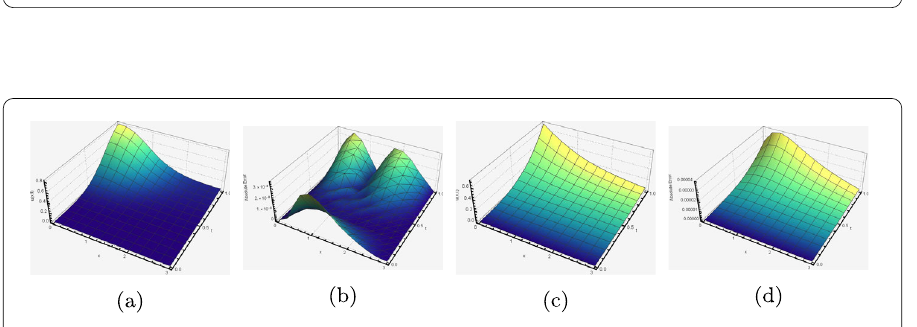
Figure 5 ( a ) and ( b ) represent approximate solution and absolute error distribution, respectively, using SJSCM. ( c ) and ( d ) represent approximate solution and absolute error distribution, respectively, using the non-polynomial B-spline method of Example 1 at α 1 = α 2 = 0.4, N = 12, 0 ≤ x ≤